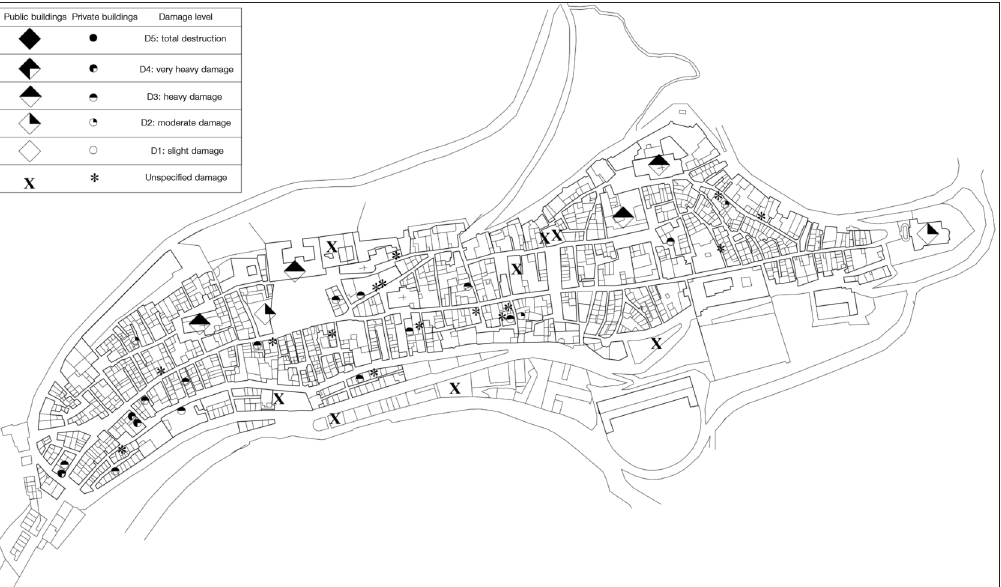
Fig. 9. 1930 damage ‘scenario’ for Potenza. It can be noticed that the damage is especially located in the cen- tral-western and western portion of the historical centre.